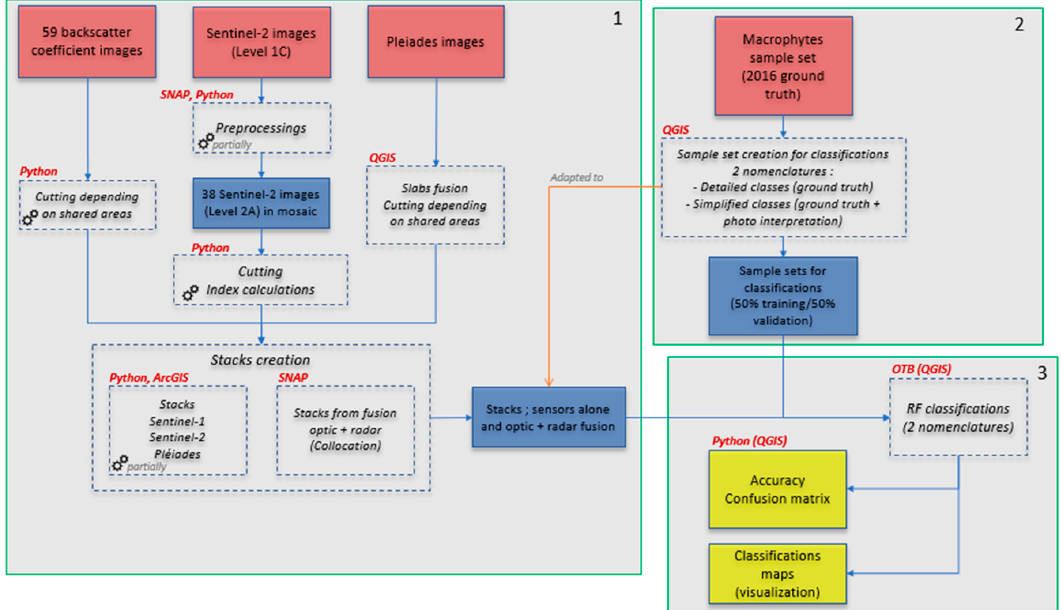
Figure 4. Process flowchart for classification of macrophytes. The red rectangles correspond to the basic data, the blue ones to the intermediate data, the yellow ones to the final products created, and those in dotted lines to the processing images.